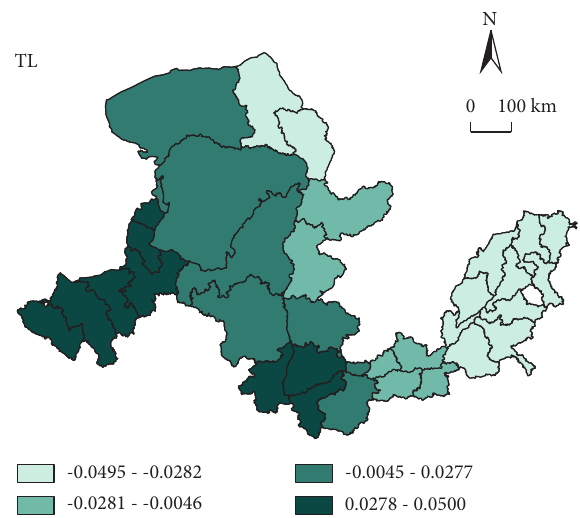
Figure 11: Spatial distribution of regression coefficient of the EDL on